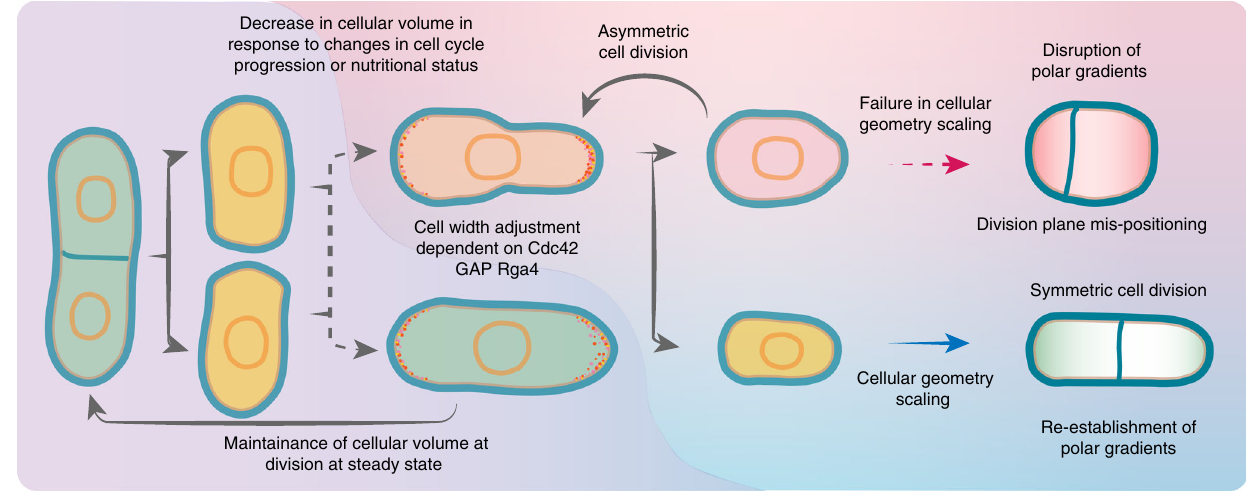
Fig. 6 Summary diagram. This diagram summarizes our current understanding of cellular geometry rescaling rules following changes in cell volume at division in response to cell cycle or nutritional cues in fi ssion yeasts. Such morphological transition produces two daughter cells with distinct growth modes that eventually in fl uence cortical patterning of the actomyosin for division plane